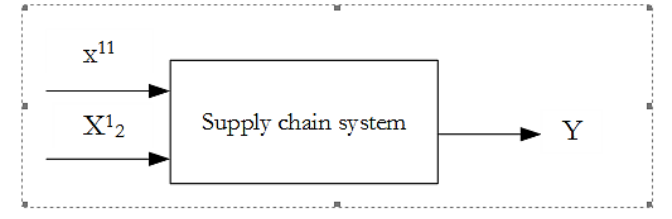
Fig. 4. Supply chain system.